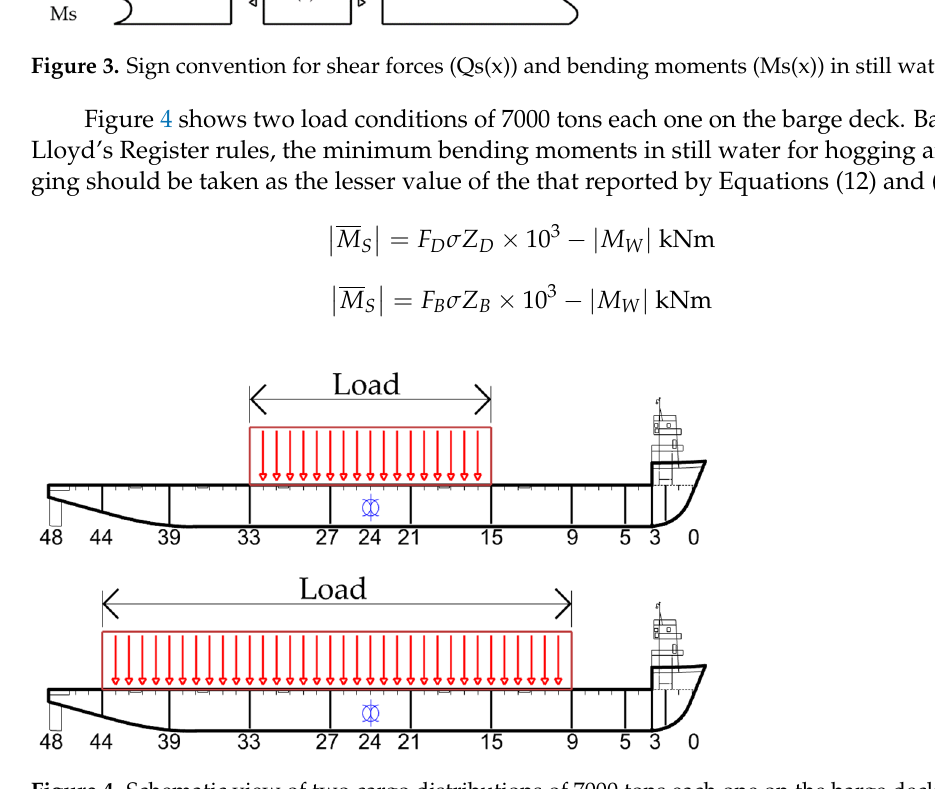
Figure 4. Schematic view of two cargo distributions of 7000 tons each one on the barge